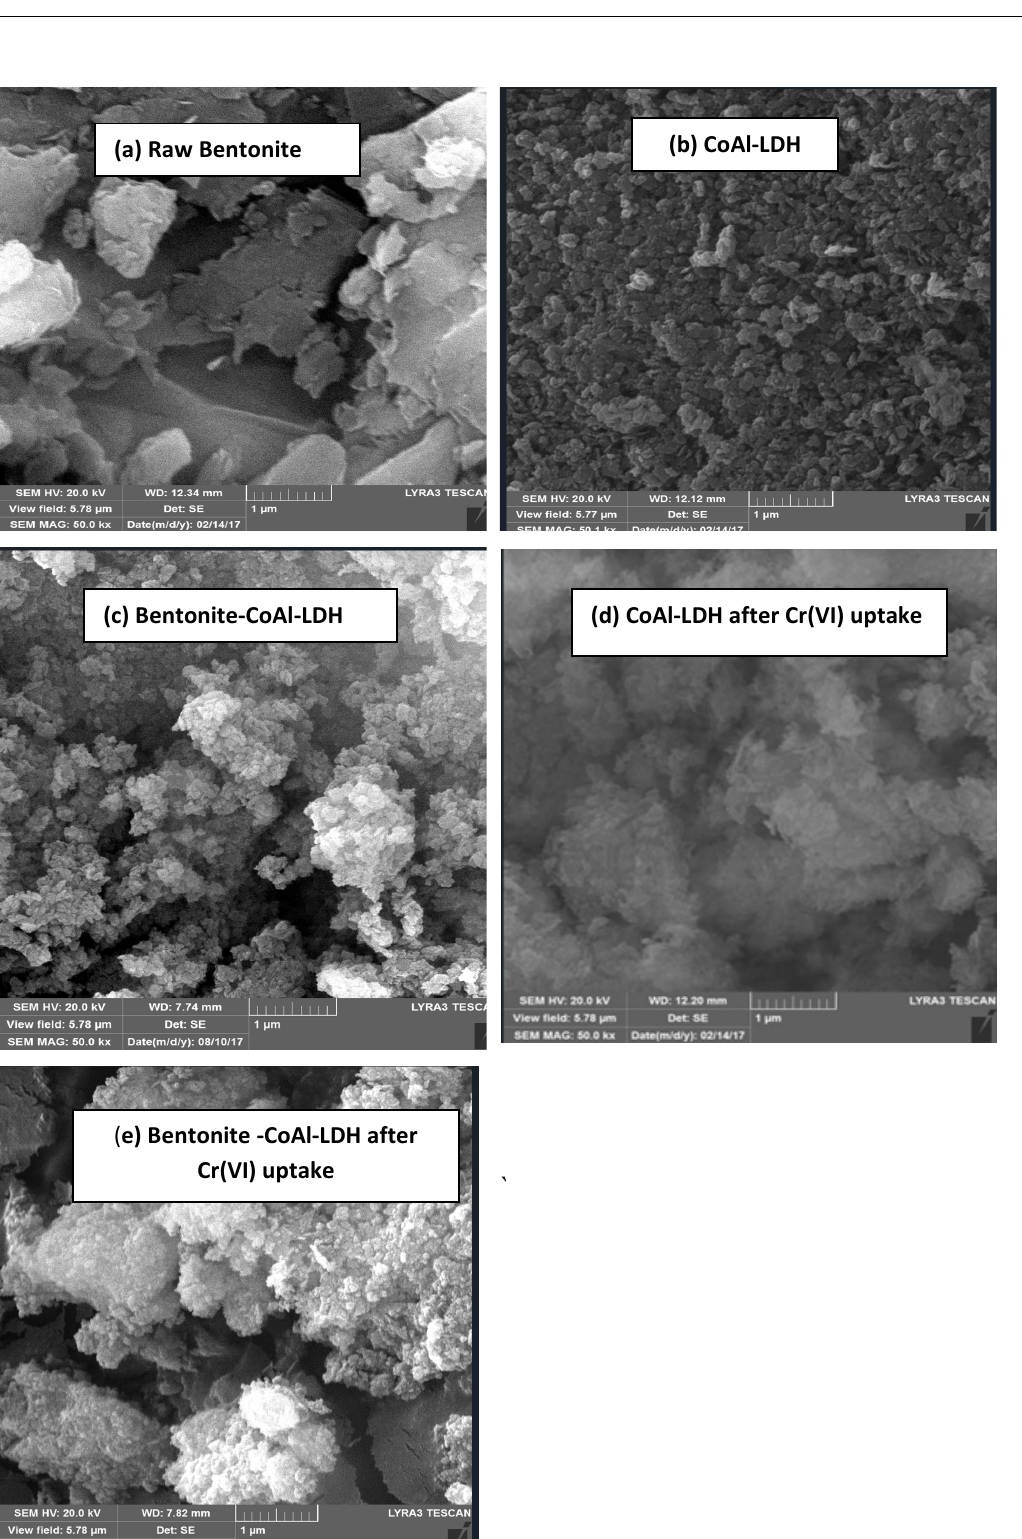
Figure 2. SEM image of raw bentonite ( a ); CoAl-LDH before Cr(VI) uptake ( b ); bentonite-CoAl-LDH before Cr(VI) uptake ( c ); CoAl-LDH after Cr(VI) uptake ( d ) and bentonite-CoAl-LDH after Cr(VI) uptake ( e ) under optimal adsorption conditions of temperature = 25 °C, pH 2 and 126 mg/L initial Cr(VI) concentration .